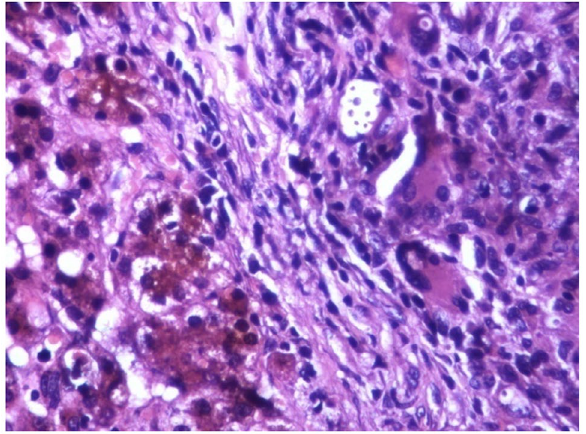
Figure 1: Photomicrograph of liver biopsy showing cholestasis and granulomatous inflammation with yeast forms of Cryptococcus within giant cells as well as lying extracellularly. (H&E, X 400).